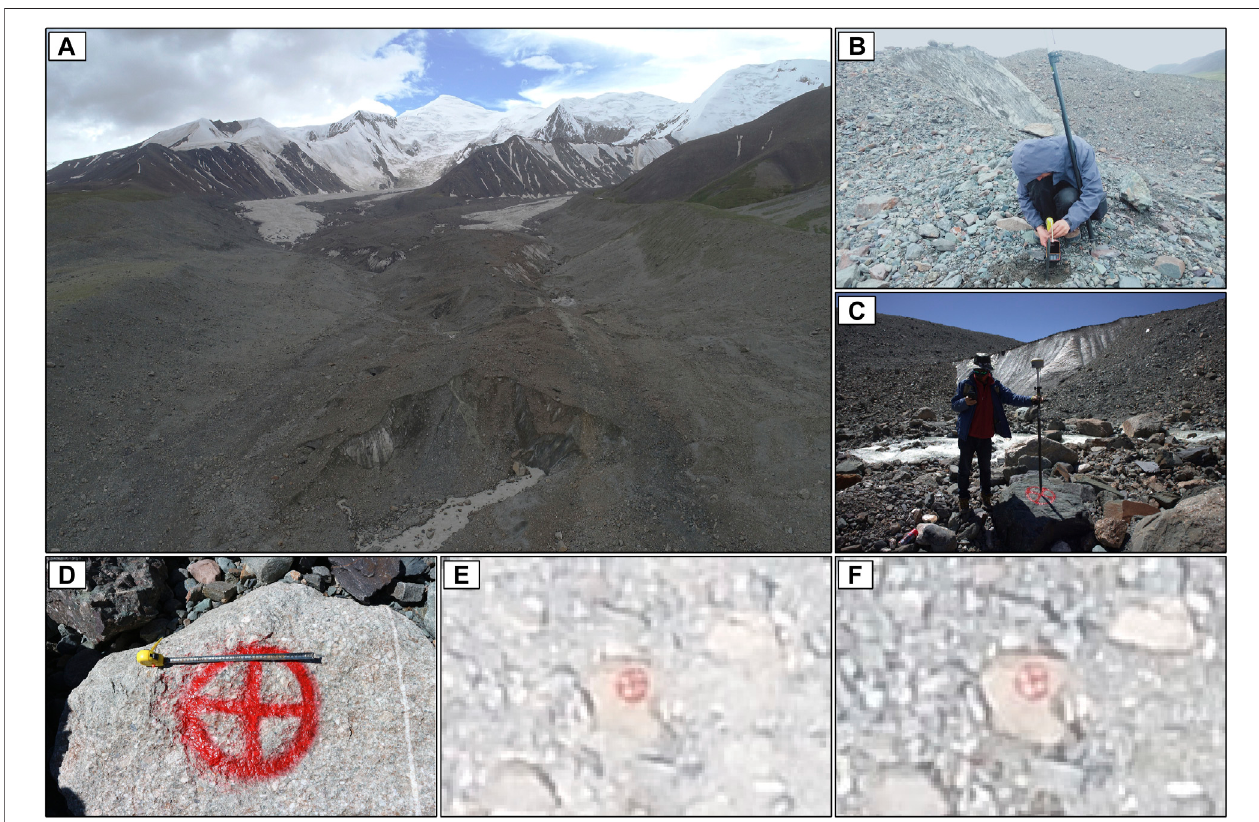
FIGURE2| FieldphotosofHalongGlacier (A) ,measurementsofdebristhickness (B) andUAVGCP (C) andtheirpainting (D) ,aswellasthesamepointphotoedby UAV at ∼ 50 m height on August 11 (E) and September 15 (F) .